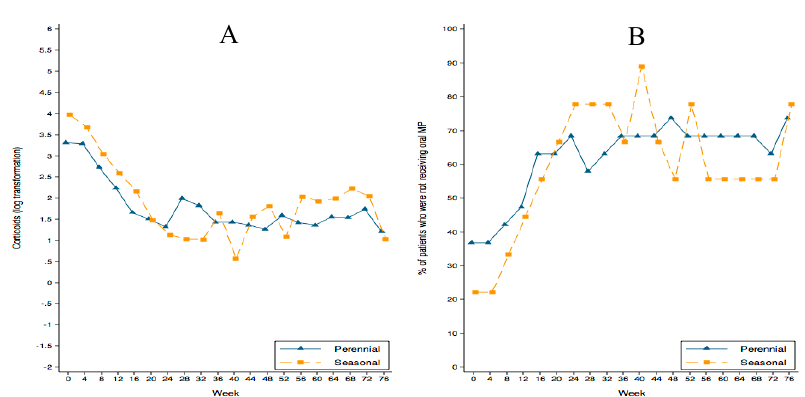
Figure 2. ( A ) Log-transformation of the oral corticosteroid dose decrease. ( B ) The progressive increase in the percentage of patients who were not receiving oral methyl-prednisolone (MP) during the study ( p < 0.001); there were no differences between groups.